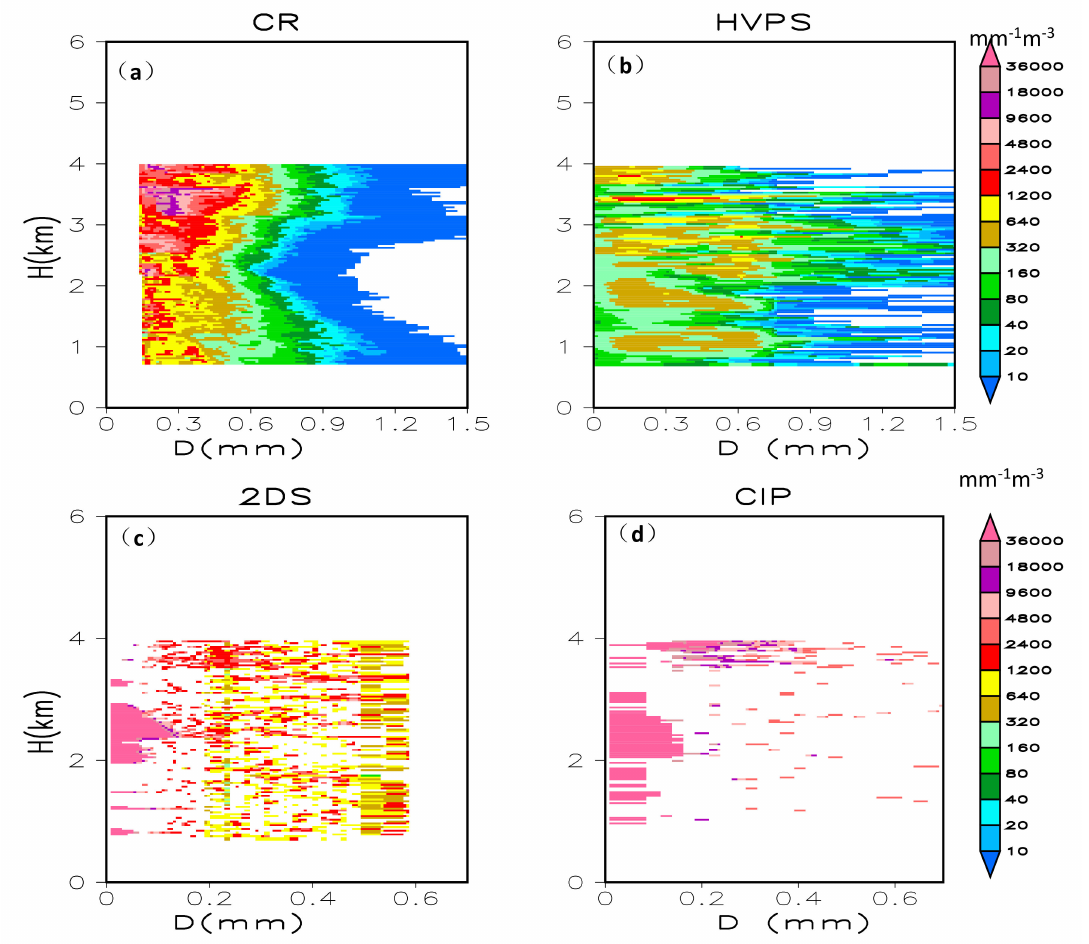
Figure 8. Retrieved drop size distribution (mm − 1 m − 3 ) at 13:18 by cloud radar (CR) ( a ) and observed DSD with the HVPS ( b ), 2DS ( c ) and CIP ( d ) between 13:17 and 13:49 CST.